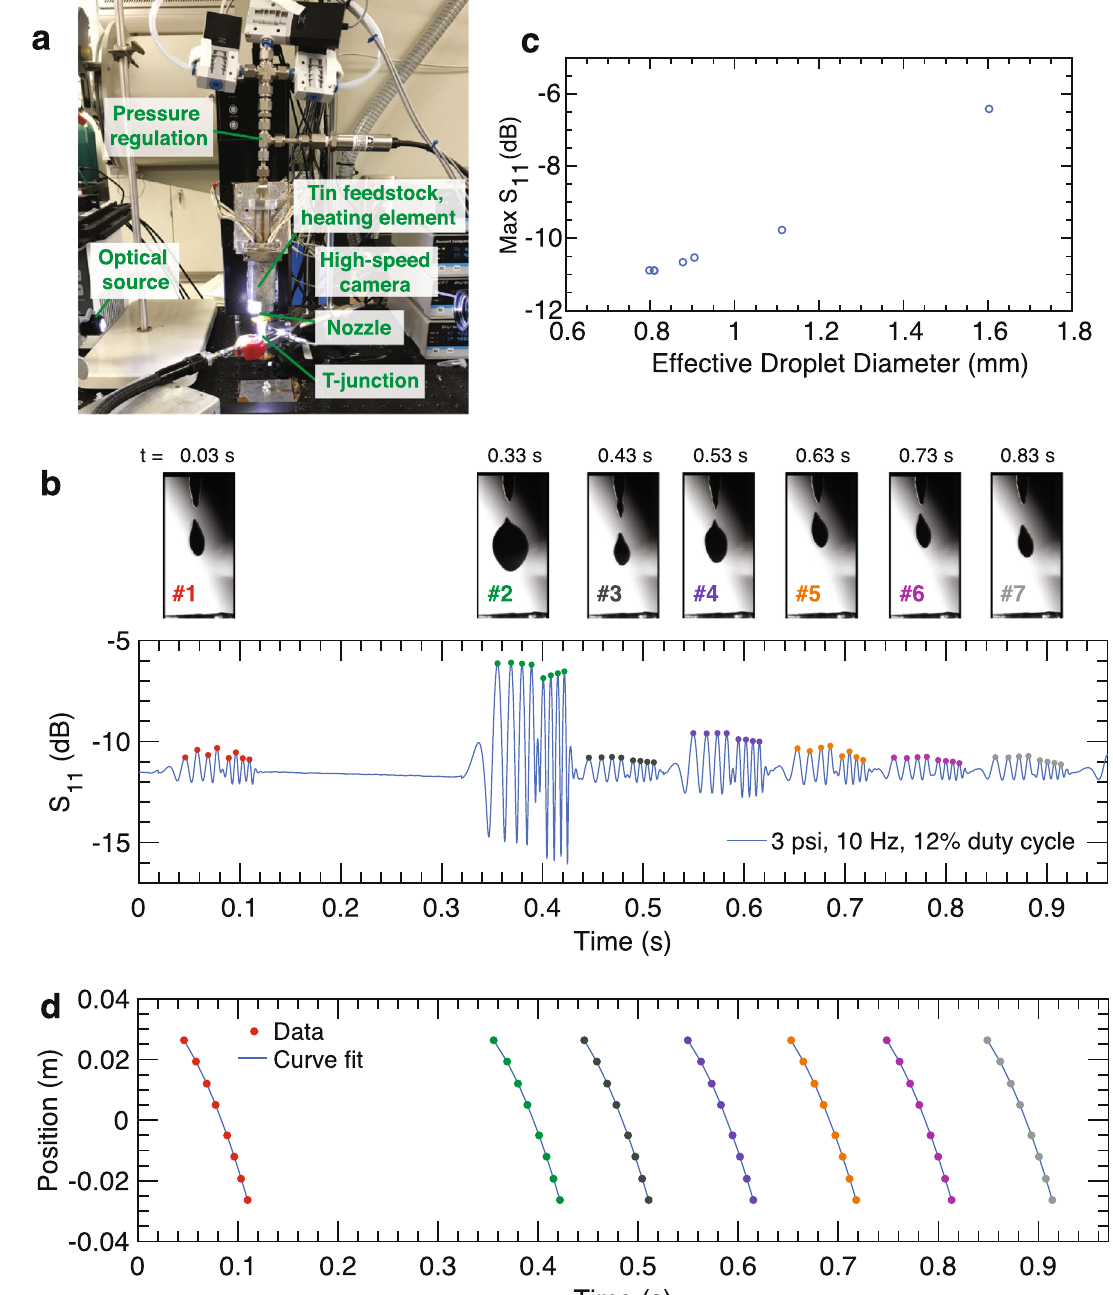
Figure 4. Liquid metal experiments. ( a ) Experimental setup in liquid metal jetting drop-on-demand system. ( b ) Time-domain S 11 measurement on tin droplets for a 200 um nozzle with 10 Hz pressure pulses. Peak values are denoted with colored markers. Images of jetted droplets are shown above the corresponding S 11 signal perturbation. ( c ) Peak S 11 value (averaged over 8 peaks) for each droplet plotted as a function of effective droplet diameter. ( d ) Droplet position (height, z-axis) over time for each droplet. Colored markers correspond to known peak locations and curves (blue) correspond to a second-order polynomial curve fit. The constants yielded by the curve fit are provided in Table